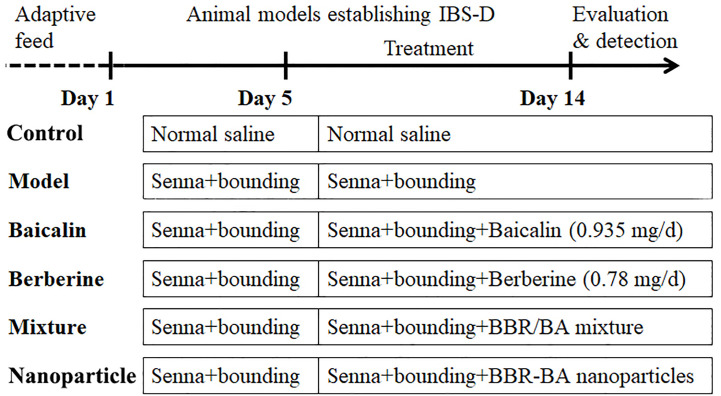
Diagram of administration.